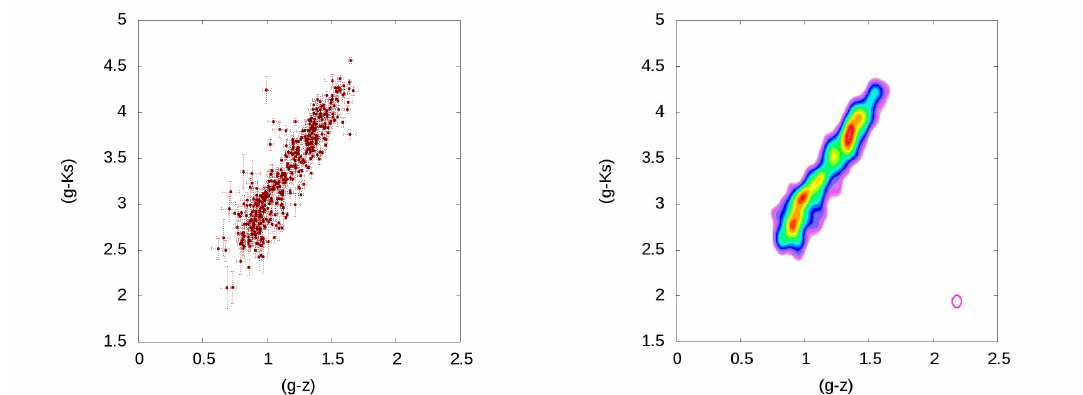
Figure 3. ( Left ): Color–color ( g (cid:48) − K s ) vs. ( g (cid:48) − z (cid:48) ) diagram built from our optical and NIR photometric sample (objects with g (cid:48) < 24 mag); ( Right ): Smoothed version of the same diagram as that on the left. The elliptical symbol depicts the kernel used to smooth the original